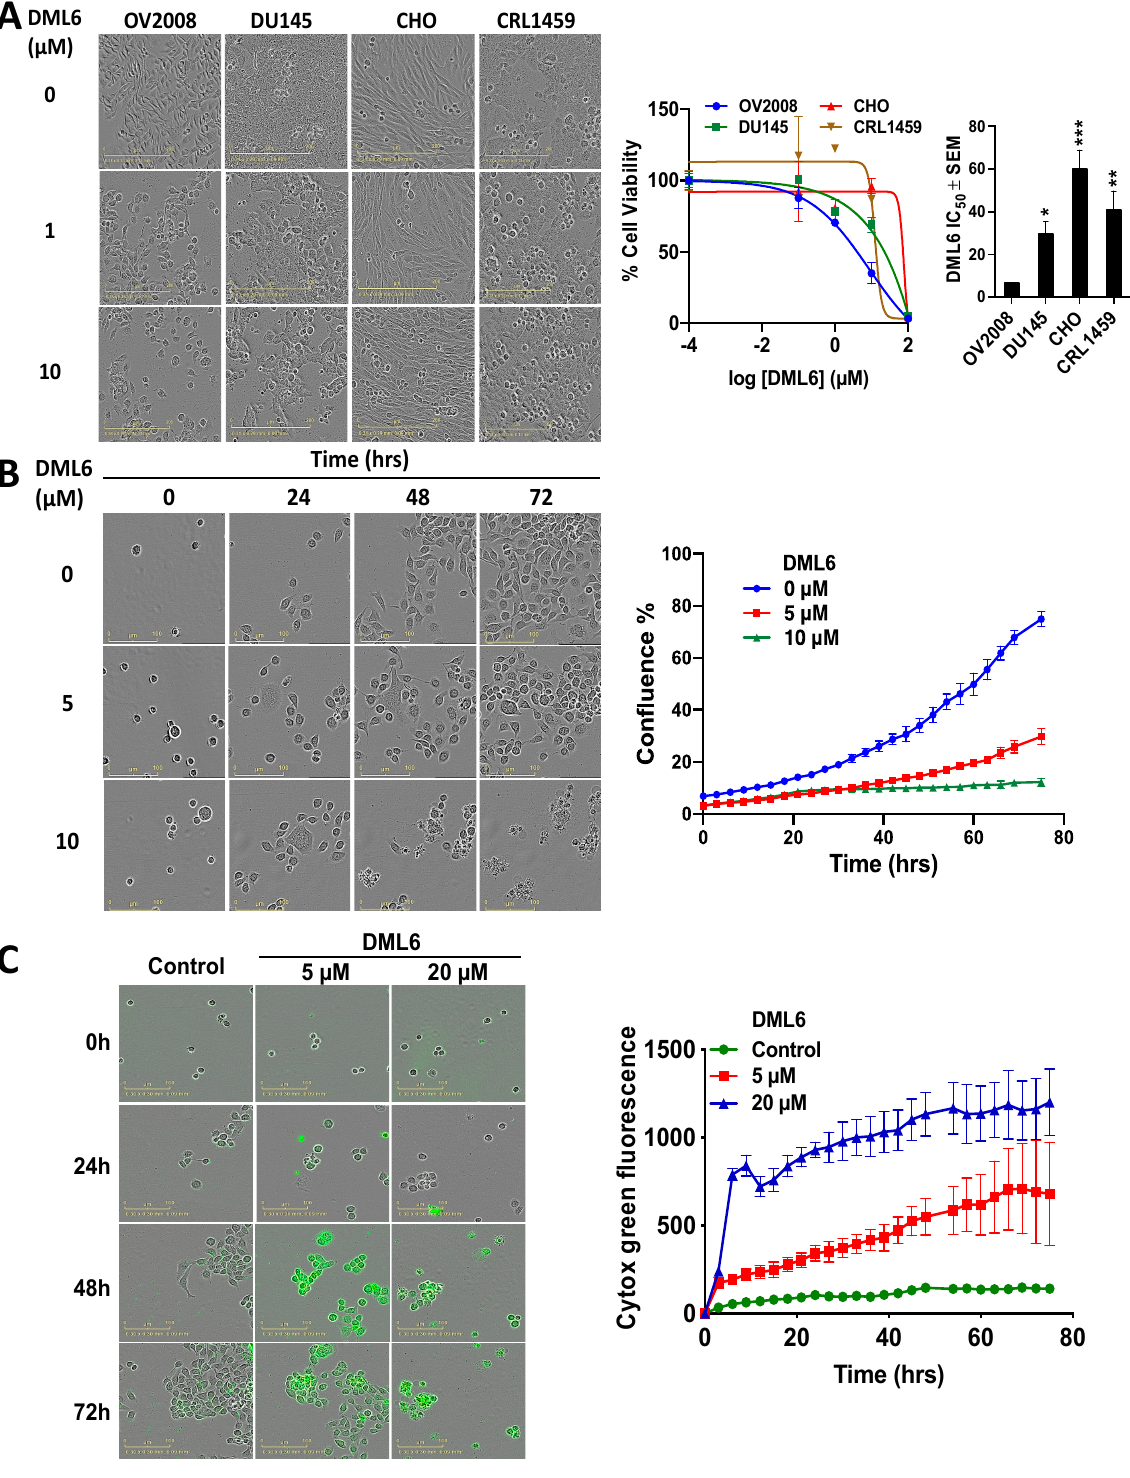
Figure 2. The efficacy and selectivity of DML-6 in OV2008 and DU145 cancer cells compared to the normal cell lines, CHO and CRL-1459. ( A ) The changes in cell morphology produced by the vehicle (0 µ M), 5 or 10 µ M of DML6 after 72 h of incubation, the cell-viability curves and the IC 50 values of DML6 for these cell lines compared to the normal cell lines.